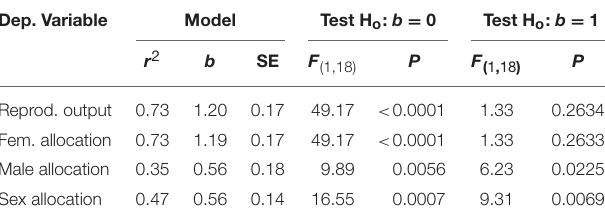
The adjusted coefficient of determination (r 2 ), the slope (b) of the curve denoting the relationshipbetweenaparticularmeasurementandbodysizeofshrimp,andthestandard error (SE) of the estimated slope are provided for each specific reproductive measure. Also, the F-statistic and the corresponding P-value obtained when testing for a positive correlation for linearity between a particular reproductive measurement and body size are presented.